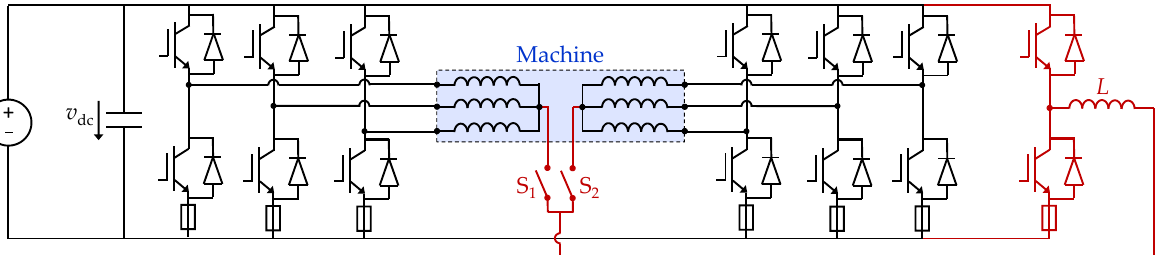
Figure 12. Fault-tolerant six-phase topology from